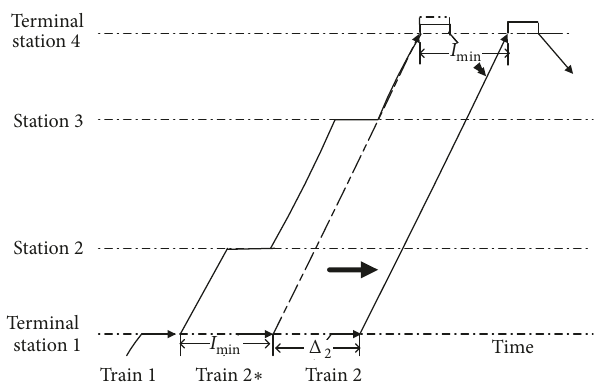
Figure 3: The illustration of the method to obtain the train safety